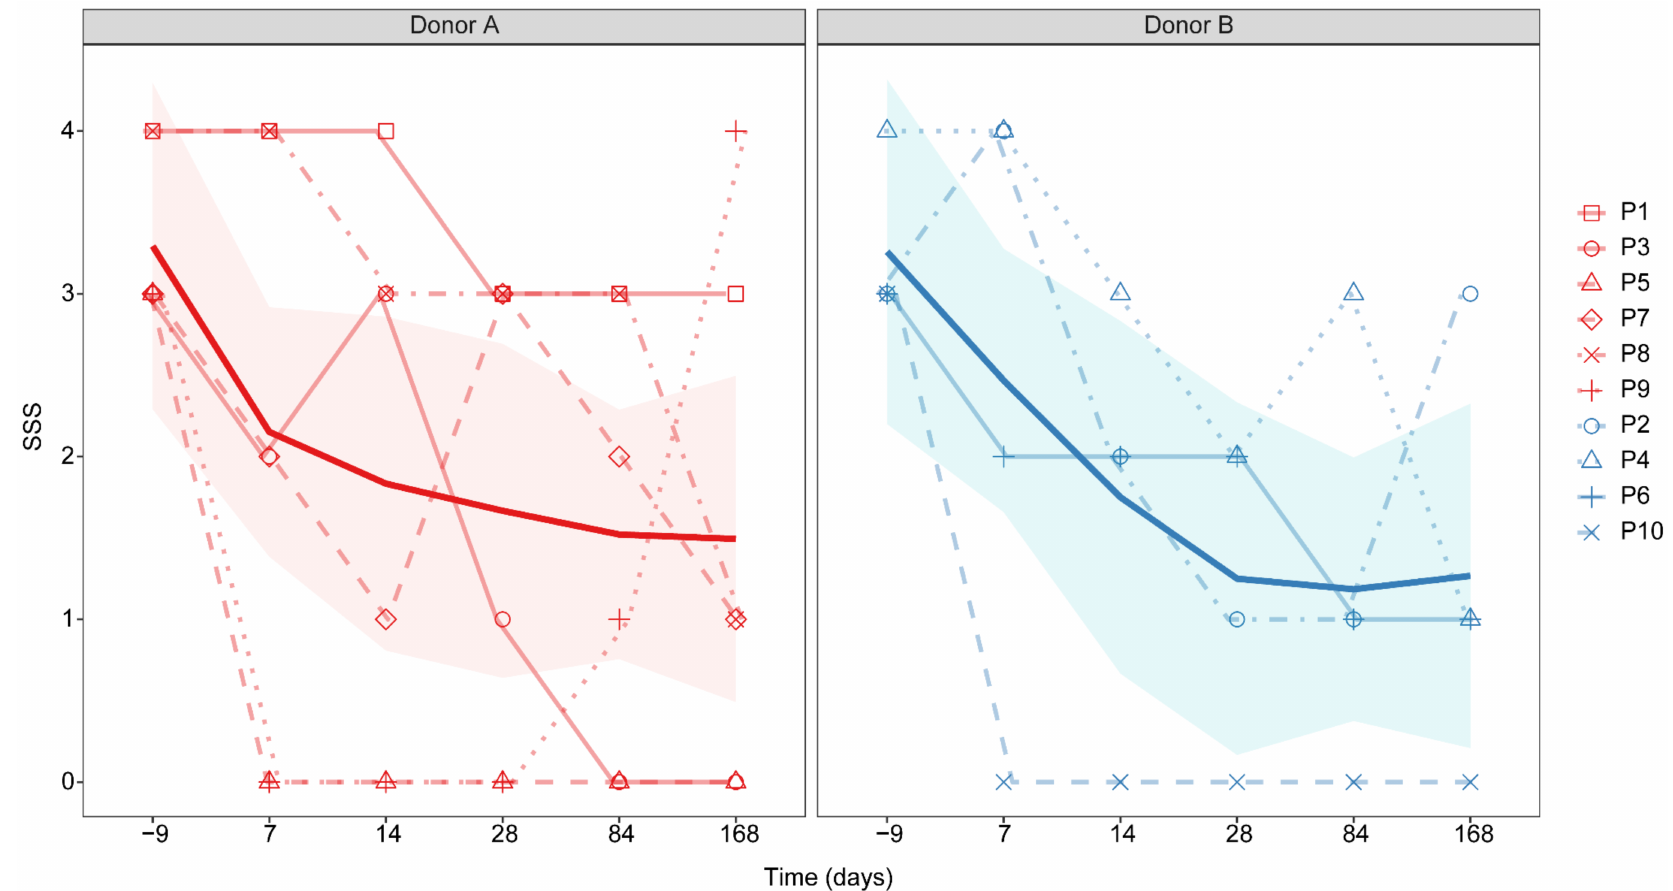
Figure 5. Plots showing the symptom severity scale (SSS) grades of the FFW horses (P1 to P10) in the study before (d –9) and after FMT (d 7, d 14, d 28, d 84 and d 168) with donor inocula prepared from either animal A or B. The bold line in each plot shows the median SSS grade for the FFW horses treated by the same